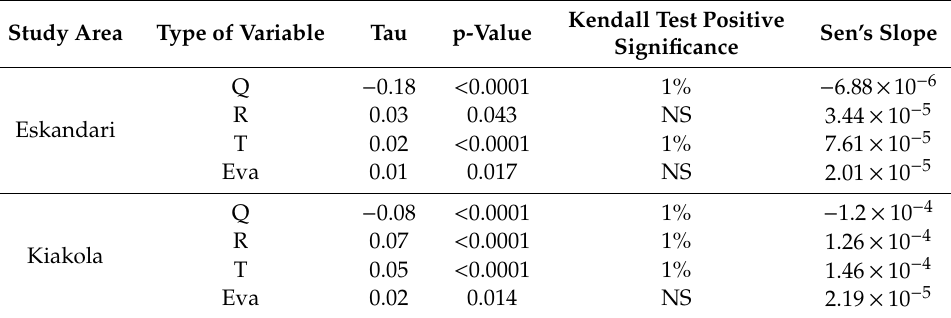
Table 1. The Mann–Kendall test’s results.